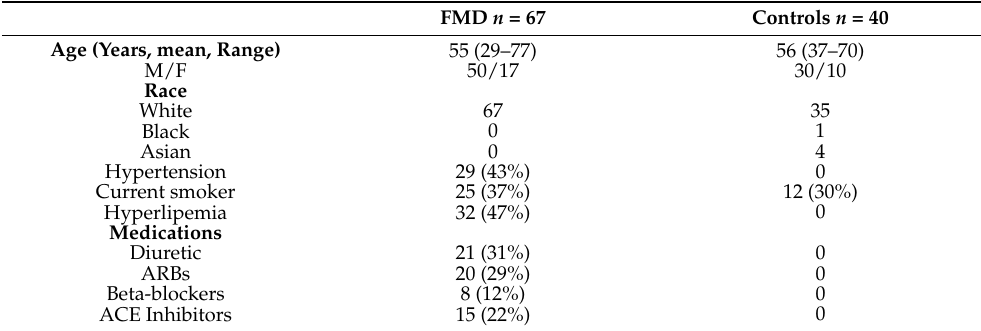
Table 1. Main clinical characteristics of patients. ARBs: angiotensin receptor blockers. ACE inhibitors: Angiotensin